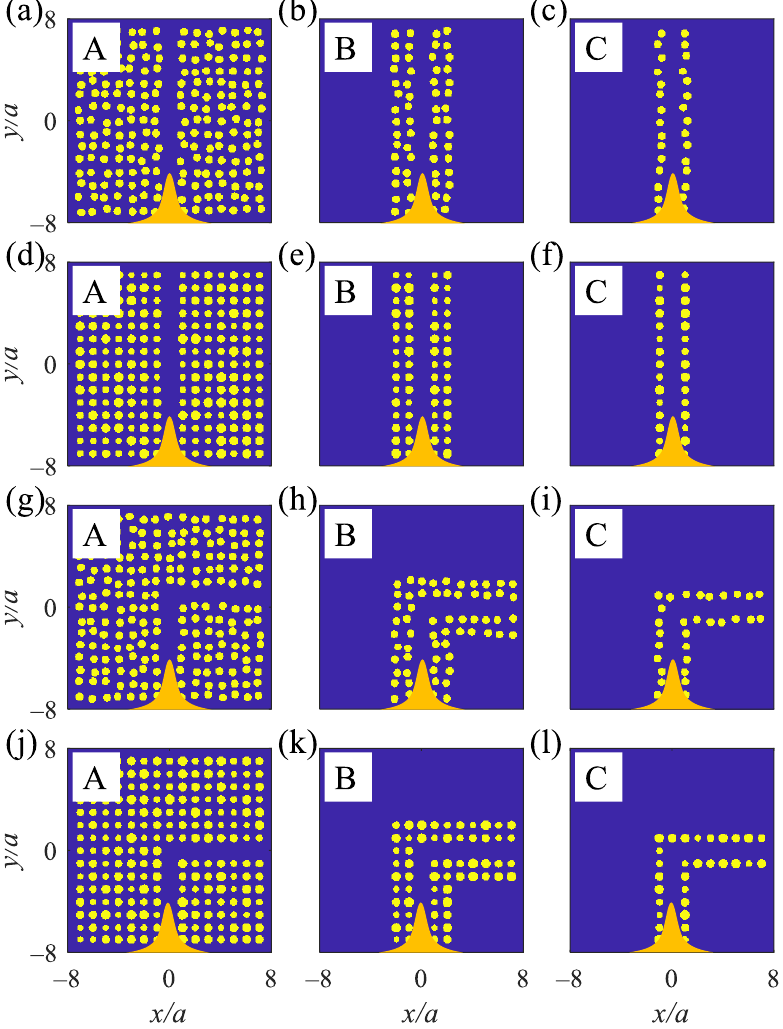
Figure 5. 2D MPHCwaveguides contain Ag rods in air. ( a – f ) show straight waveguides of A, B, and C at η p = 19% and η r = 24%, respectively. ( g – l ) show A, B, and C-type L-shaped waveguides at η p = 19% and η r = 24%, respectively. At the bottom of the waveguides, the orange bell shapes are Gaussian waves that propagate from - y to y and are recorded at the top and right of the straight and L-shaped waveguides, respectively—yellow: Ag rods and blue: